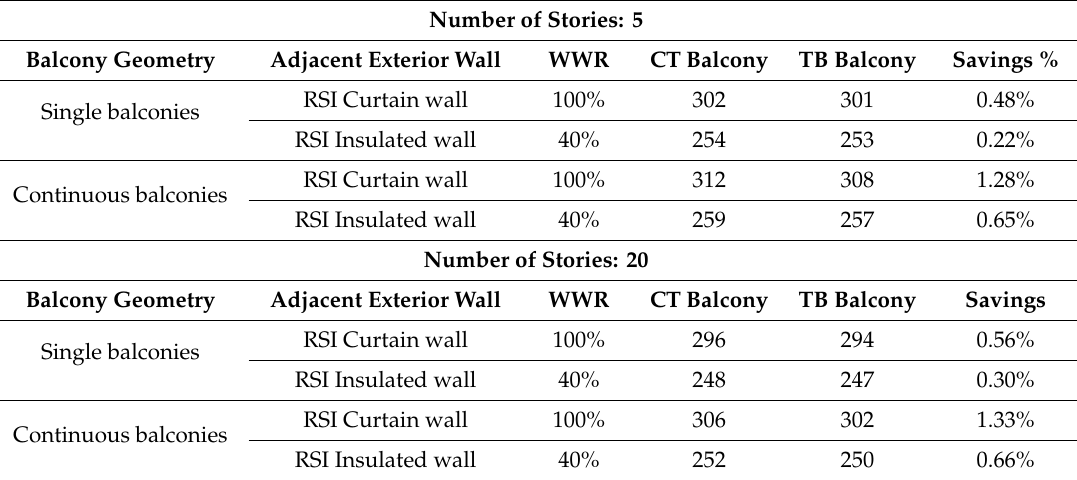
Table 6. The total annual energy use intensity (kWh / m 2 ) and energy use reduction.